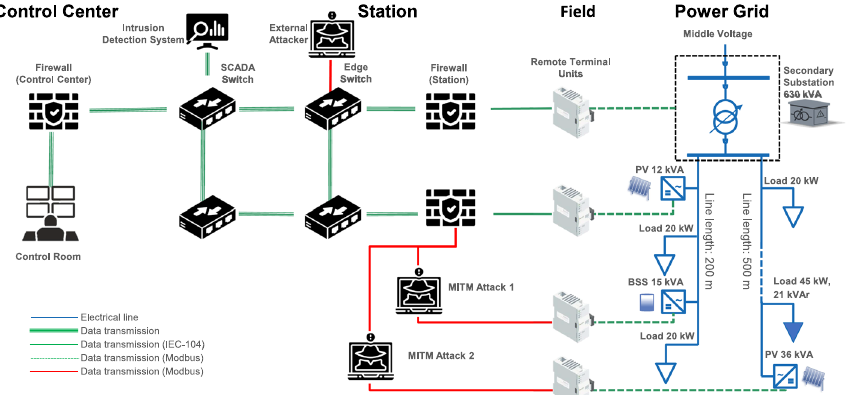
Fig. 6 Our setup of a SG testbed replicates a distribution grid with DERs and ICT infrastructure for control and